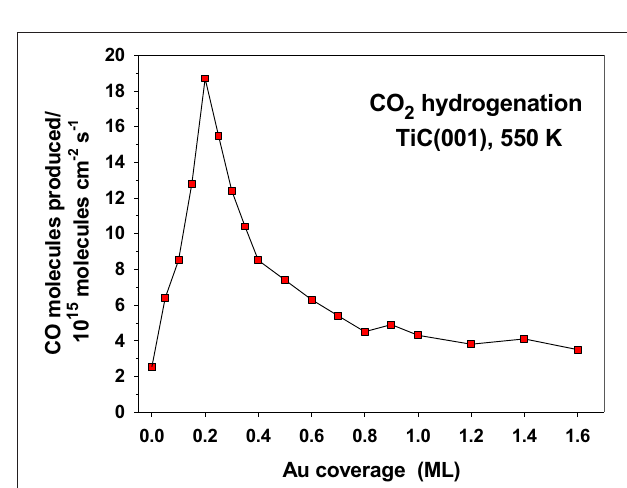
FIGURE 12 | Rate for the yield of CO during the hydrogenation of CO 2 on a series of Au/TiC(001) surfaces. T = 550K, P CO2 = 0.5 atm, P H2 = 4.5 atm. Reproduced with permission from Posada-Pérez et al. (2016), copyright 2016 by the American Chemical Society.